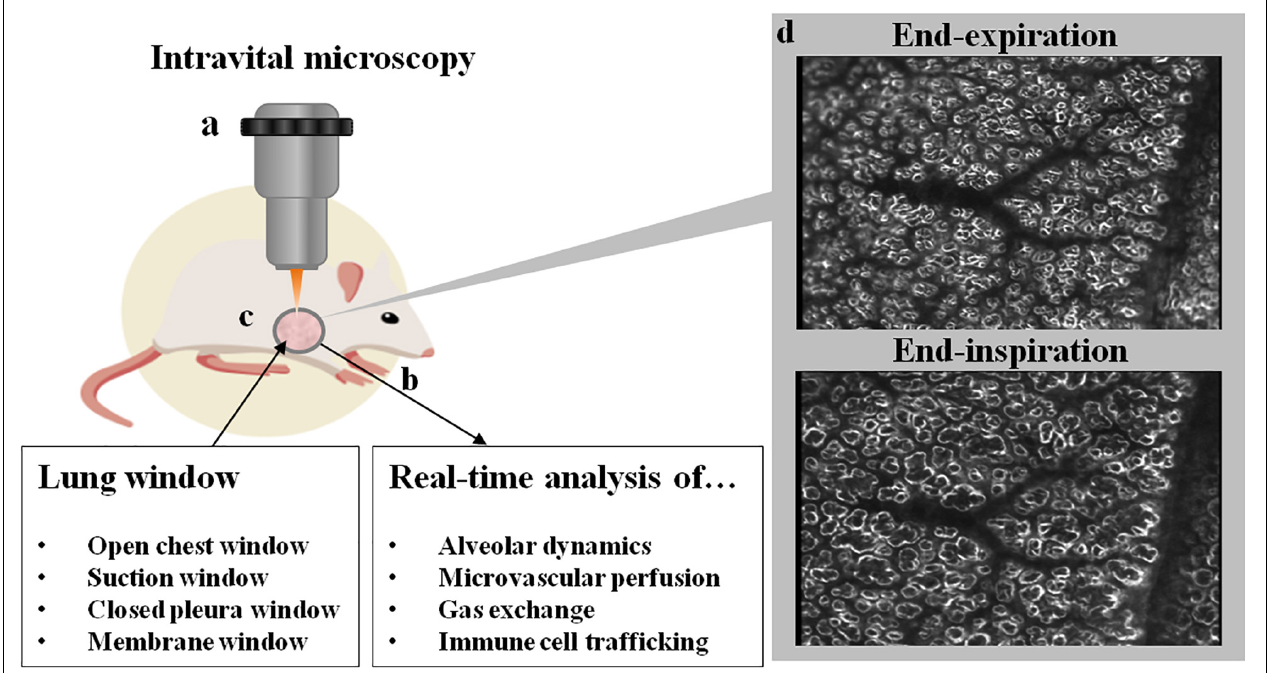
FIGURE 1 | Schematic overview of a lung window and IVM. Intravital microscopy (a) is typically performed in mechanically ventilated animals ( b ; e.g., mouse, rat, swine, dog). Access to the lung is gained via excision of a surgical window (c) from the thoracic wall, with different types of windows currently in use. Imaging can be performed with several light microscopic applications ranging from widefield microscopy to multiphoton microscopy. In (d) two representative images of subpleural alveoli imaged by darkfield illumination at end-inspiration and end-expiration are shown. In the center of the image, a vascular tree can be seen with its terminal branches, surrounded by alveoli which distend during inspiration. On the right side of the image, the rim of the lung lobe can be seen. Ethical approval for the animal experiment was obtained from the Animal Care Committee of St. Michael’s Hospital Toronto. The figure was designed using resources from